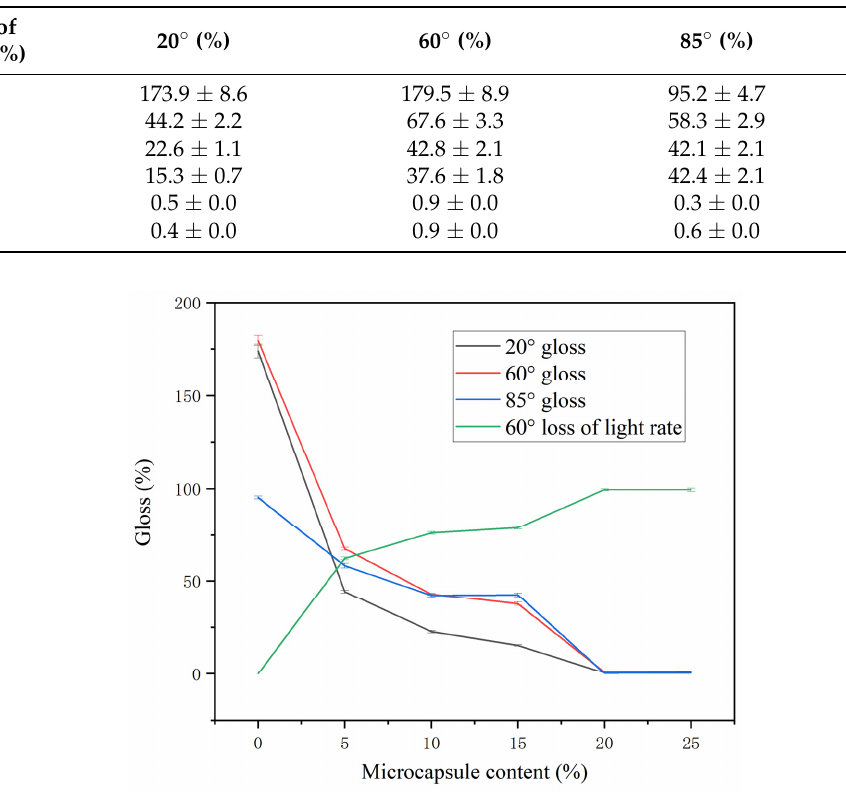
Figure 6. A gloss of coating with different microcapsule content.